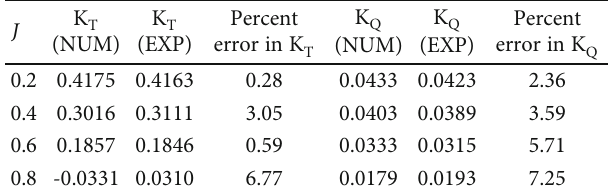
Table 4: Comparison of numerical data with experimental data